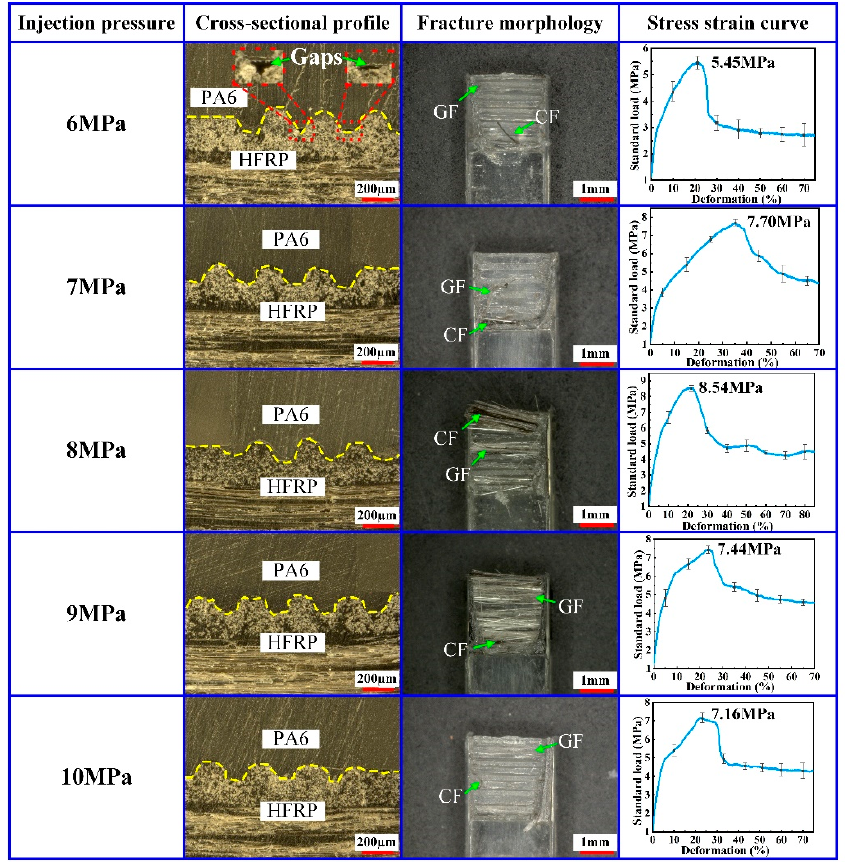
Figure 4. Effect of injection pressure on the injection molding quality of composite parts. When the injection pressure was 6 MPa, gaps were observed at the interface of HFRP and PA6. Correspondingly, the micro-grooves on the surface of HFRP were not completely filled with PA6, which caused the poor injection molding quality of the composite part. As the injection pressure increased, the PA6 could fill the micro-groove structure on the HFRP surface more easily, and the injection molding quality of the composite part could be increased efficiently. When the injection pressure increased from 6 MPa to 8 MPa, the residual CF and GF on the fracture surface of the composite part increased gradually, and the tensile strength increased from 5.45 MPa to 8.54 MPa. However, as the injection pressure increased over 8 MPa, the residual CF and GF on the fracture surface of compo- site parts started to decrease gradually, and the tensile strength also decreased. When the injection pressure was 10 MPa, flying edges occurred in the composite parts, which would decrease the injection molding quality. The experimental results indicated that too high or too low of an injection pressure was not favorable for improving the injection molding quality and tensile strength of com- posite parts. When the injection pressure was too low, the pressure in the mold core cavity was insufficient, leading to the insufficient filling of PA6 and thus resulting in the gaps at the interface of the HFRP and PA6 connection. When the injection pressure was suitable, the arrangement between PA6 molecules and glass fibers was more compact, thus